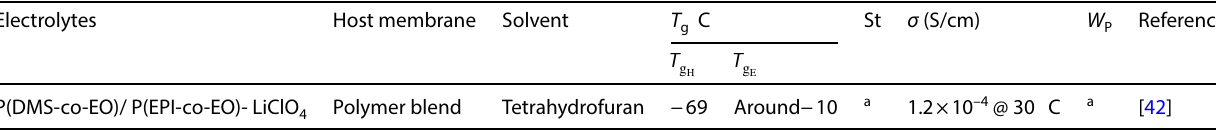
Table 1 Thermal properties, conductivity, and window potential of some PECH blend membrane electrolytes